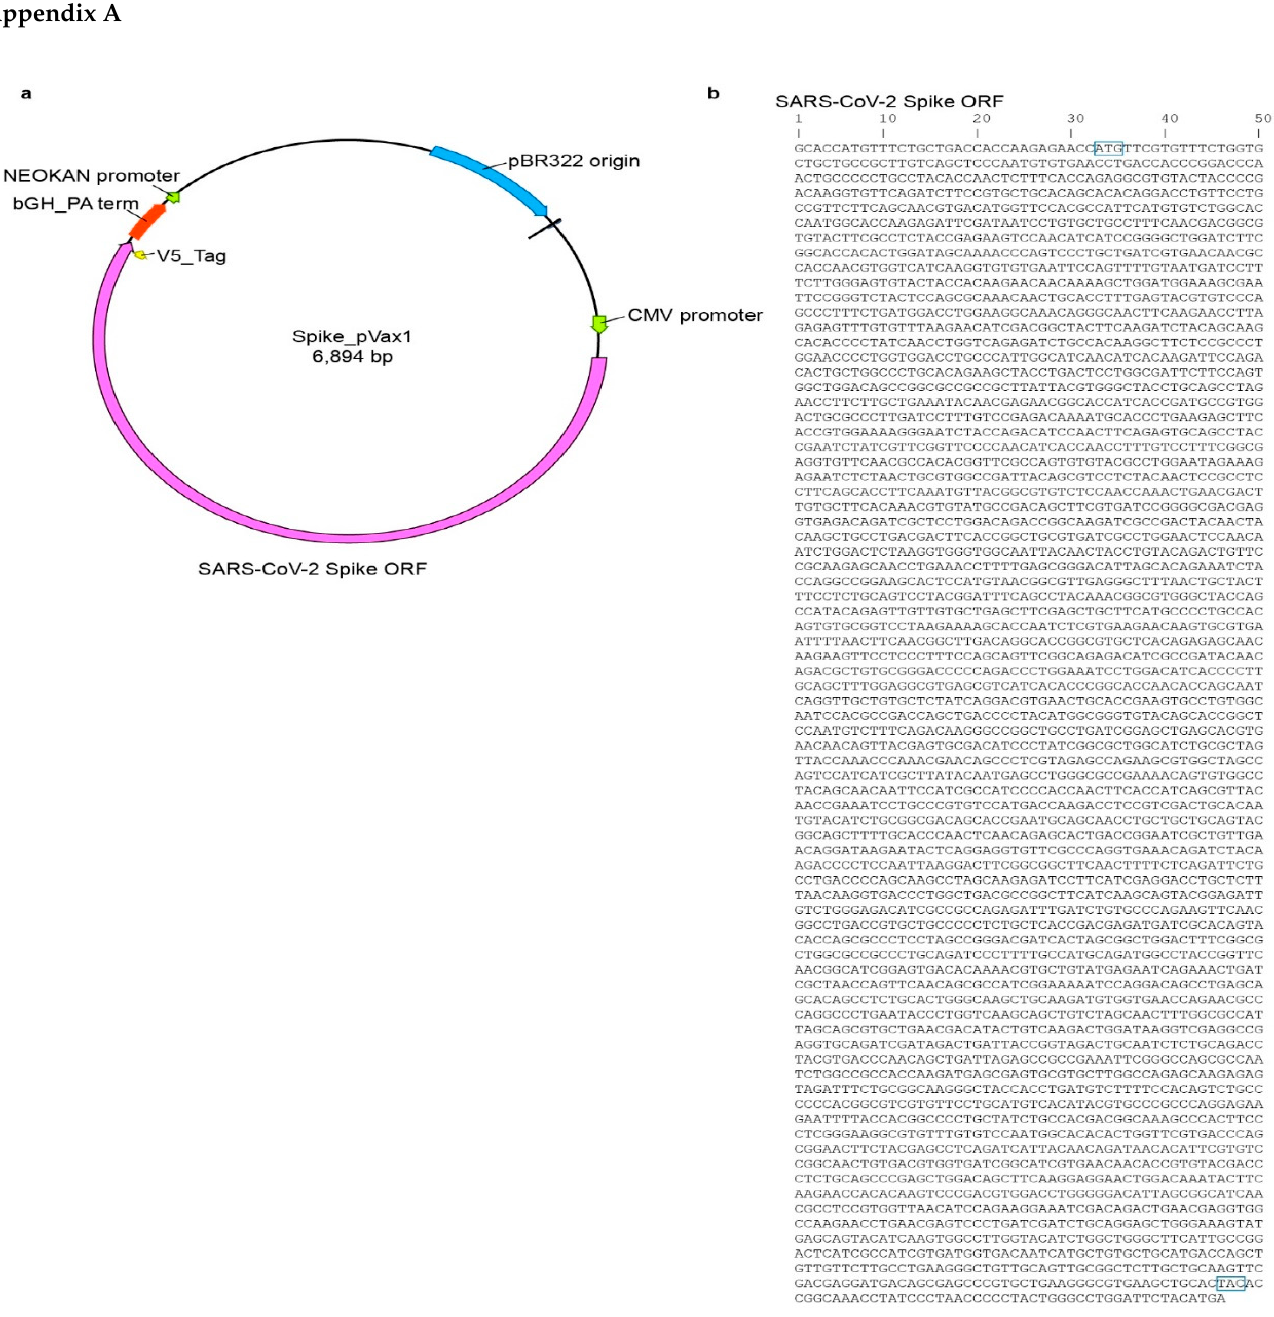
Figure A1. Sp_pVax1 Plasmid Map and Codon-Optimized SARS-CoV-2 Spike Sequence. ( a ) Spike_pVax1 plasmid map showing SARS-CoV-2 spike ORF with V5 epitope tag inserted into the pVax1 vector backbone and ( b ) codon-optimized spike sequence. The spike open reading frame start codon (ATG) and final codon (TAC) are indicated in blue boxes, the V5 epitope tag sequence immediately follows that of the spike and ends in final stop codon.